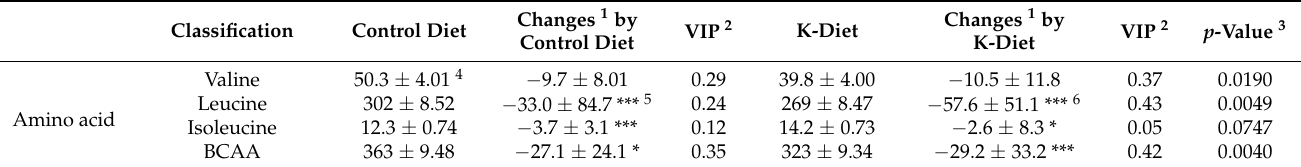
Table 5. Serum metabolites in the control diet and K-diet groups after a 4-week